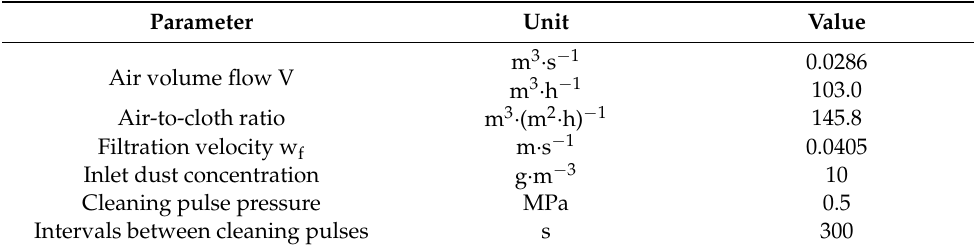
Figure 3. Test rig set-up; 1—filtration chamber, 2—filter bag, 3—supporting cage, 4—Venturi tube, 5—dust feeder, 6—dust inlet tube, 7—clean air chamber, 8—tube with cleaning nozzle, 9—compressed air tank, 10—cleaning control device, 11—outlet tube, 12—Prandtl tube, 13—differential manometer for air velocity control, 14—regulation valve, 15—main fan, 16—differential manometer for pressure drop measurements. Table 4. Filtration parameters during testing of filtration